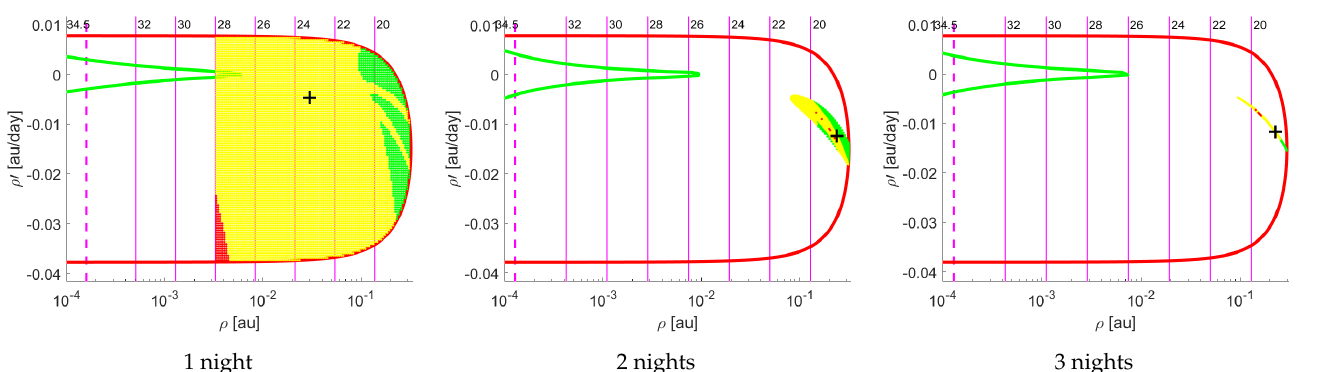
Figure 7. Test of Tool 1 for asteroid 2001CA 21 : evolution of the MOV over three nights of